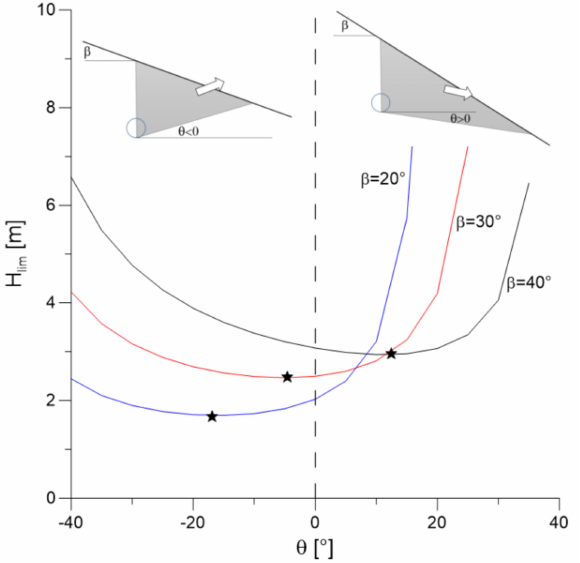
Figure 4. Limit hydraulic head as function of inclination of failure surface; stars indicate the minimum point ( D = 0.25 m, γ = 18 kN/m 3 , c = 3 kPa, φ = 31 ◦ , L h = 1